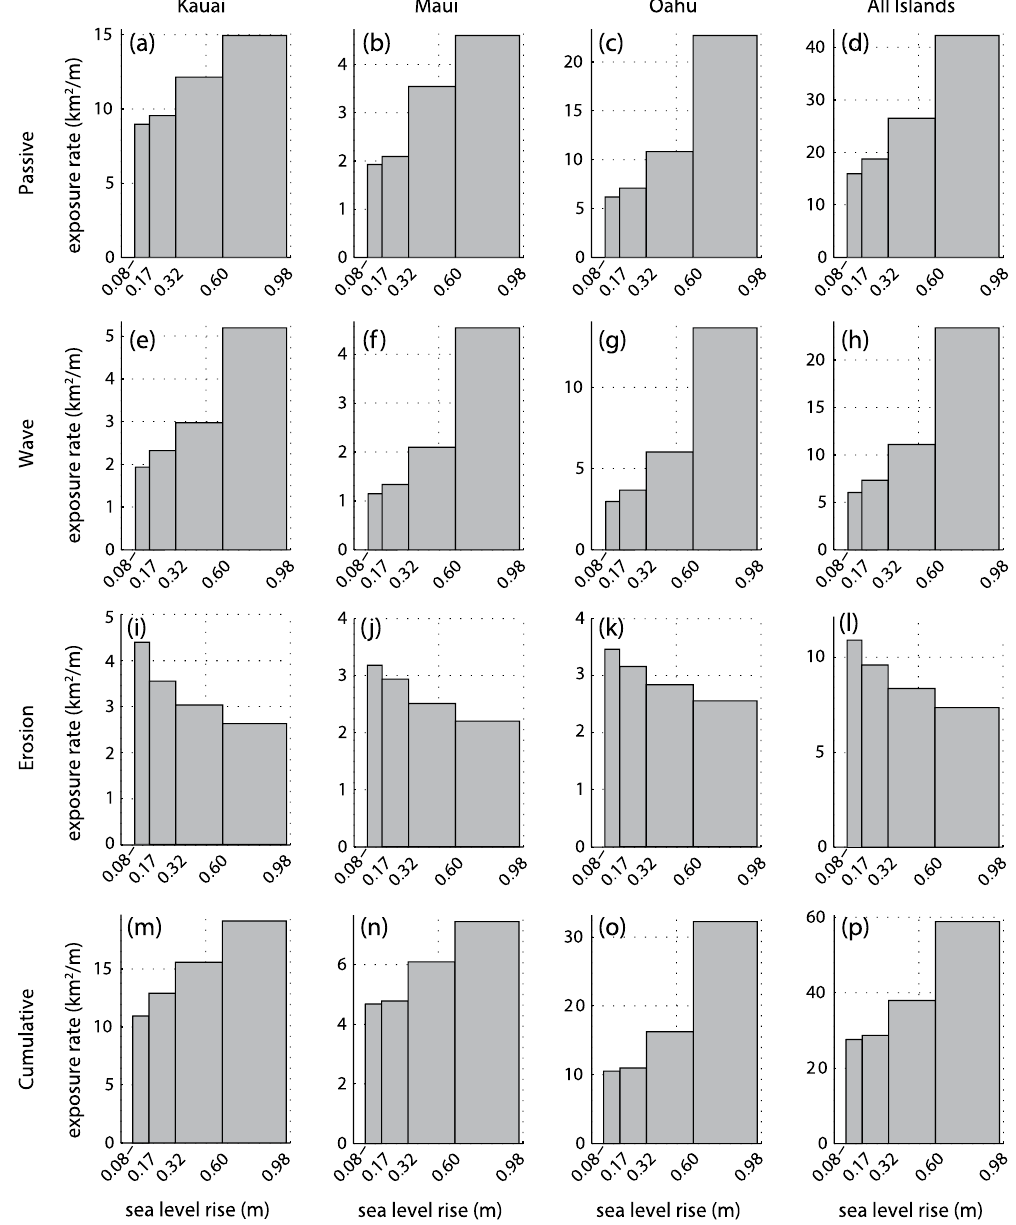
Figure 4. The simple rate at which new land becomes exposed to each SLR hazard, per unit SLR, is shown for the four intervals of higher sea level: 0.08–0.17 m, 0.17–0.32 m, 0.32–0.60 m, and 0.60–0.98 m. ( a – d ) Passive flooding exposure rates (includes both marine overland flooding, and groundwater/storm drain flooding). ( e – h ) Wave inundation exposure rates. ( i – l ) Erosion exposure rates. ( m – p ) Cumulative exposure